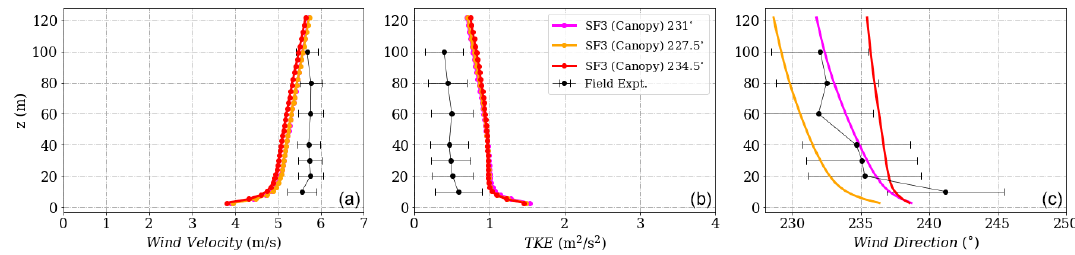
Figure D4. (a) Wind velocity magnitude, (b) wind direction and (c) turbulent kinetic energy tuned to reach calibration at height 573m corresponding to 100m at Tower 20 (tse04) for the SF3 (canopy) model.